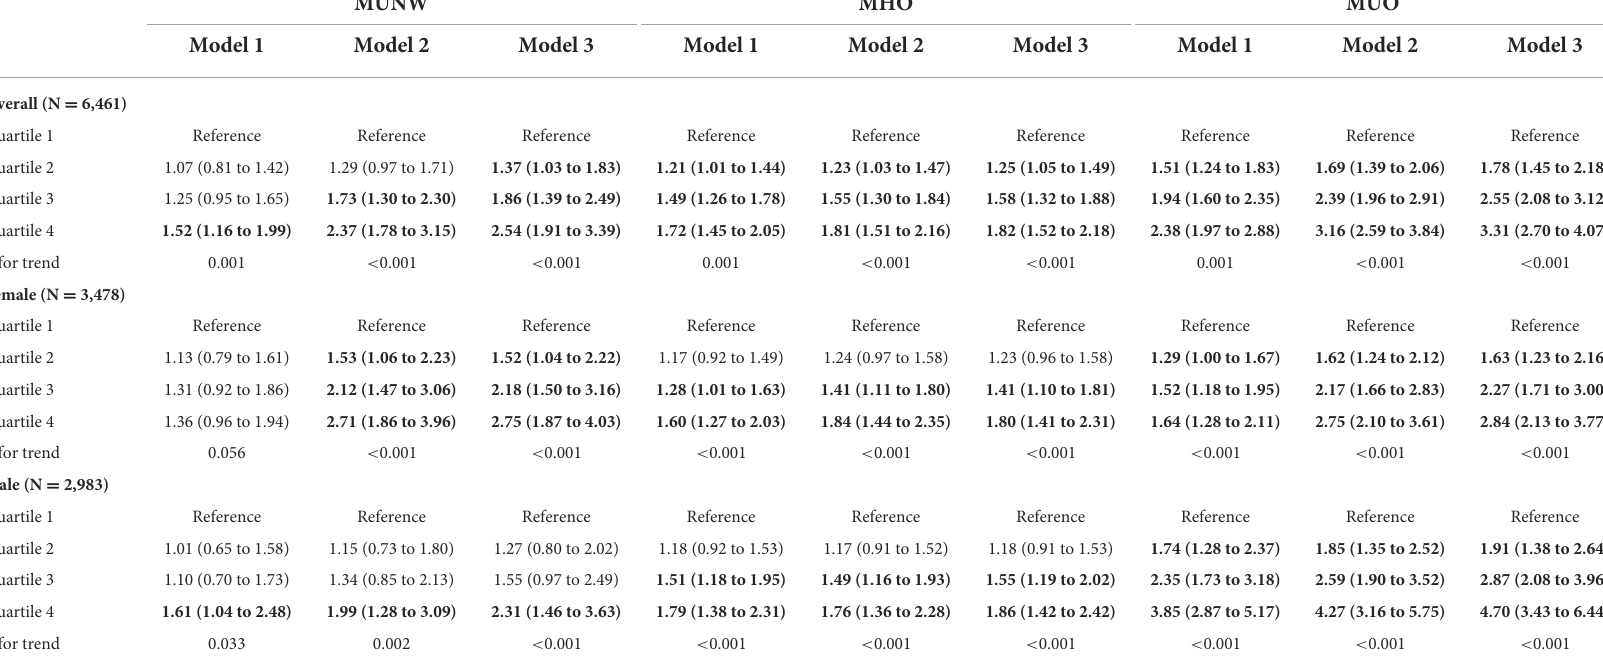
TABLE 3 Odds ratios and 95% CIs of different metabolic obesity phenotypes by transferrin levels in CHNS